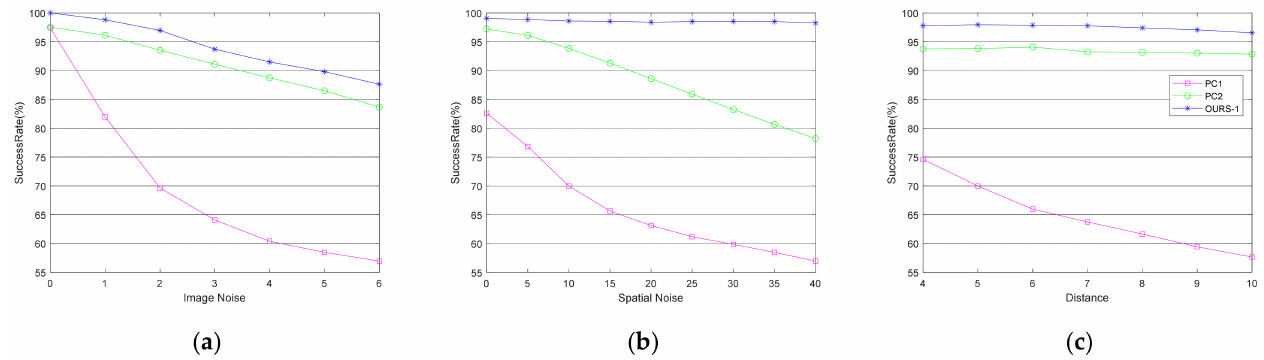
Figure 3. This is a figure showing the success rate of the algorithm under different simulation conditions. The curves corresponding to the algorithm in References [18,20] are marked as PC1 and PC2. The coordinates of the two points were set to (300, 300, 0) and (150, 150, − 500), and gaussian noise with a mean of 0 and a variance of 5 was added to the position. ( a ) The success rate of the algorithms under different levels of noise in the image; ( b ) The success rate of the algorithms under different levels of noise in the spatial structure; ( c ) The success rate of the algorithms under different z -axis coordinates of the